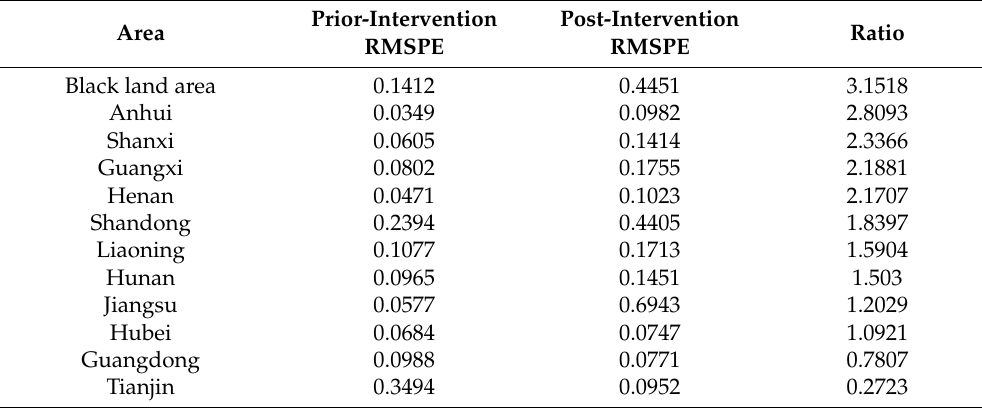
Table 5. Post/prior-RMSPE ratios for industrial sulfur emissions in the black land area and the control regions.